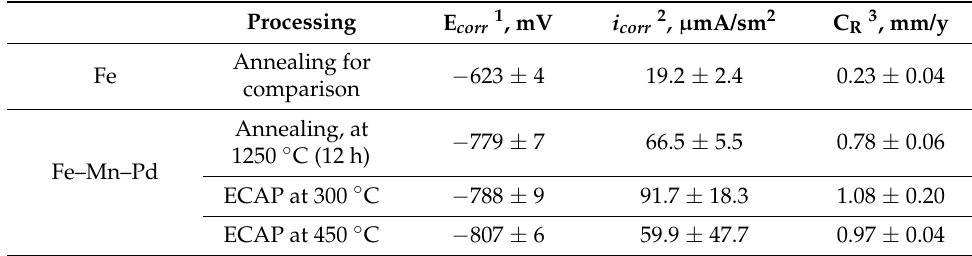
Figure 6. PDP curves in physiological saline solution at scan rate of 1 mV/s ( a ) and E vs. C R ( b ) of Fe–Mn–Pd alloy in different states and technically pure iron for comparison. Table 4. Potentiodynamic polarization parameters of Fe–Mn–Pd alloy in physiological saline solution.